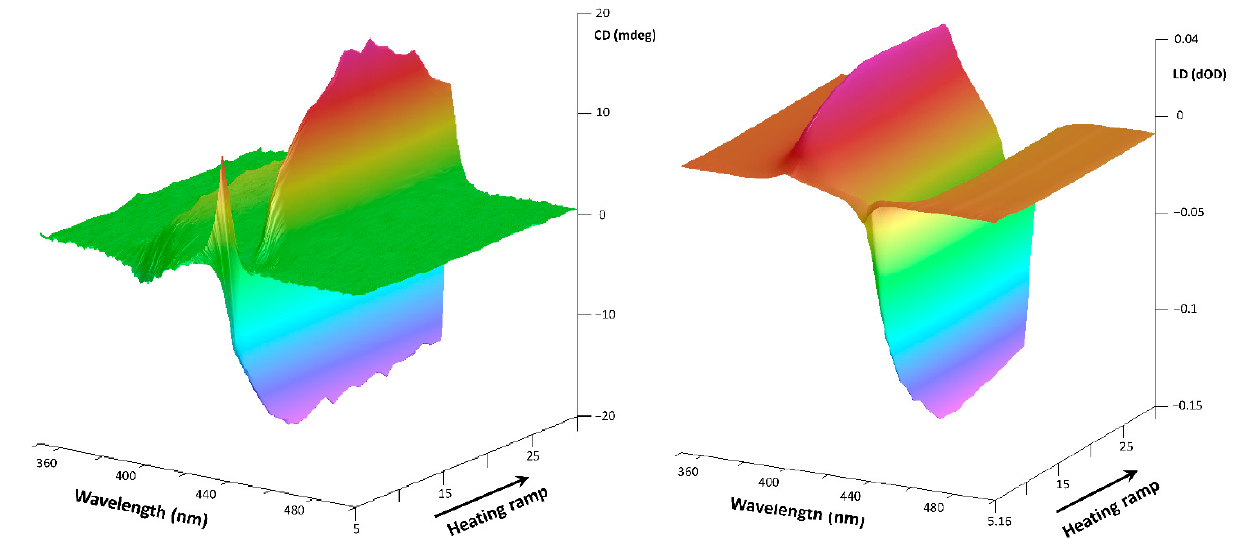
Figure 11. 3D CD spectra of the water solution of StarP-R, acquired in thermal heating ramp ( left ) and the relative 3D LD spectra ( right ), in the temperature interval 5–30 °C, relatively to the aggregates having size >0.45 µm.